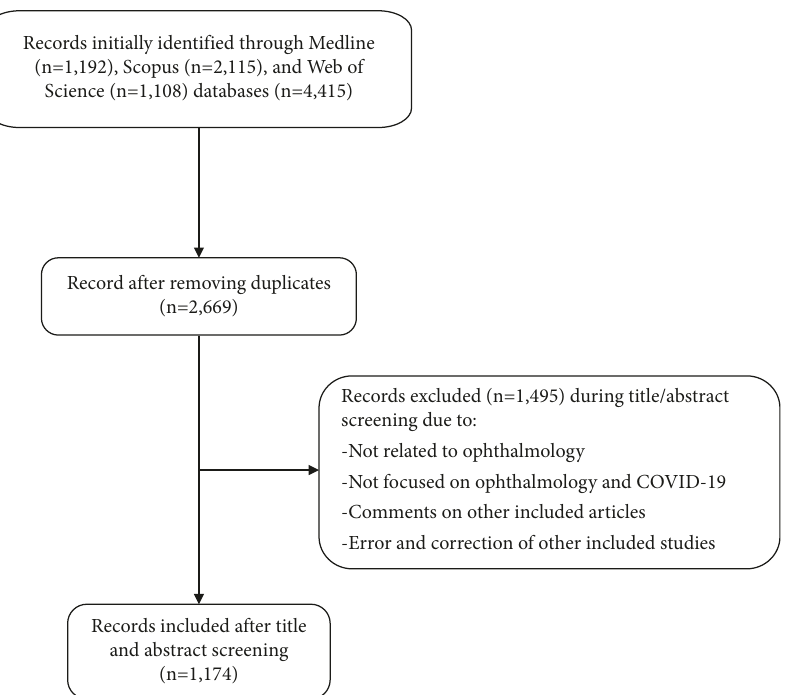
Figure 1: Flowchart of the article selection process (COVID-19: Coronavirus